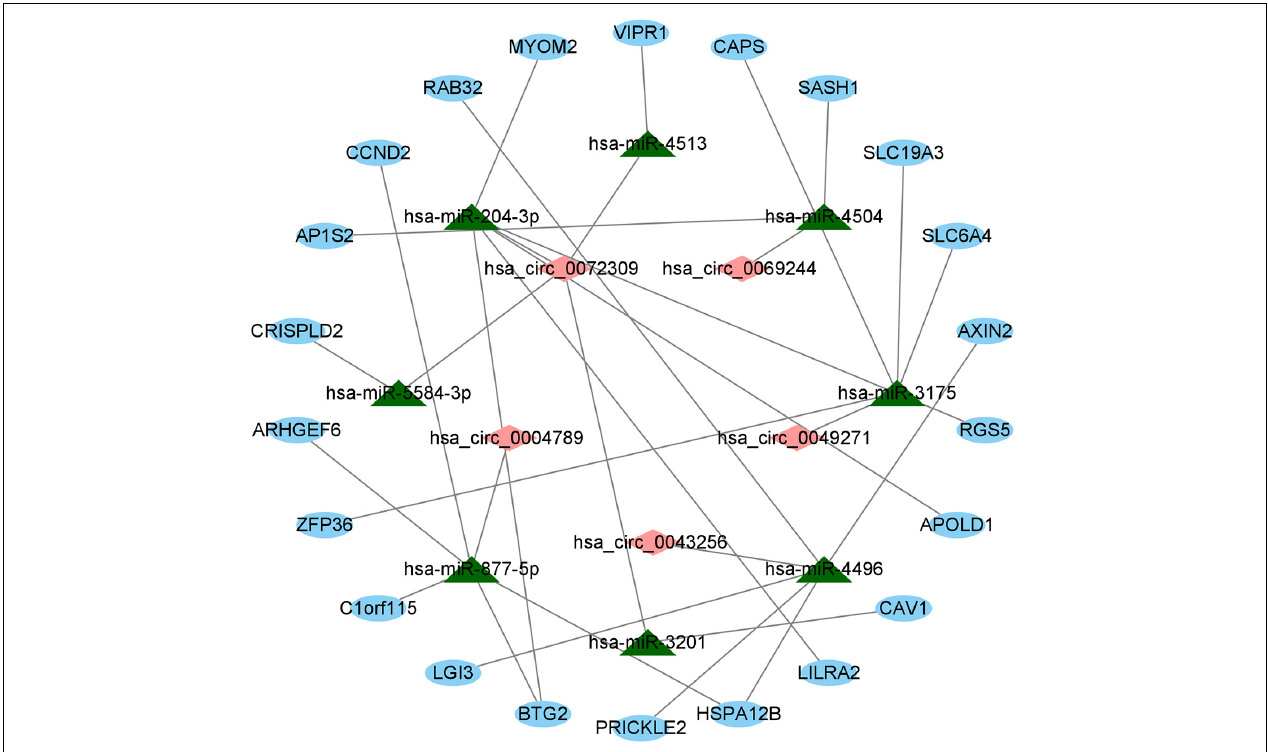
FIGURE 5 | The ceRNA regulatory network on basis of circRNA–miRNA pairs and miRNA–mRNA pairs in LUAD. Red diamonds indicate circRNAs, green triangles indicate miRNAs, and blue ovals indicate mRNAs.